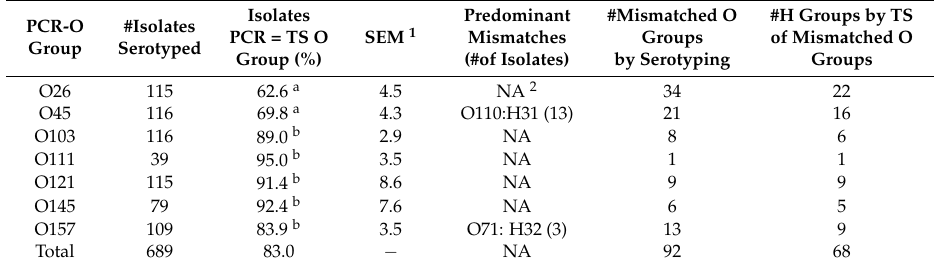
Table 1. Differences between PCR and traditional serotyping (TS) for O group determination among